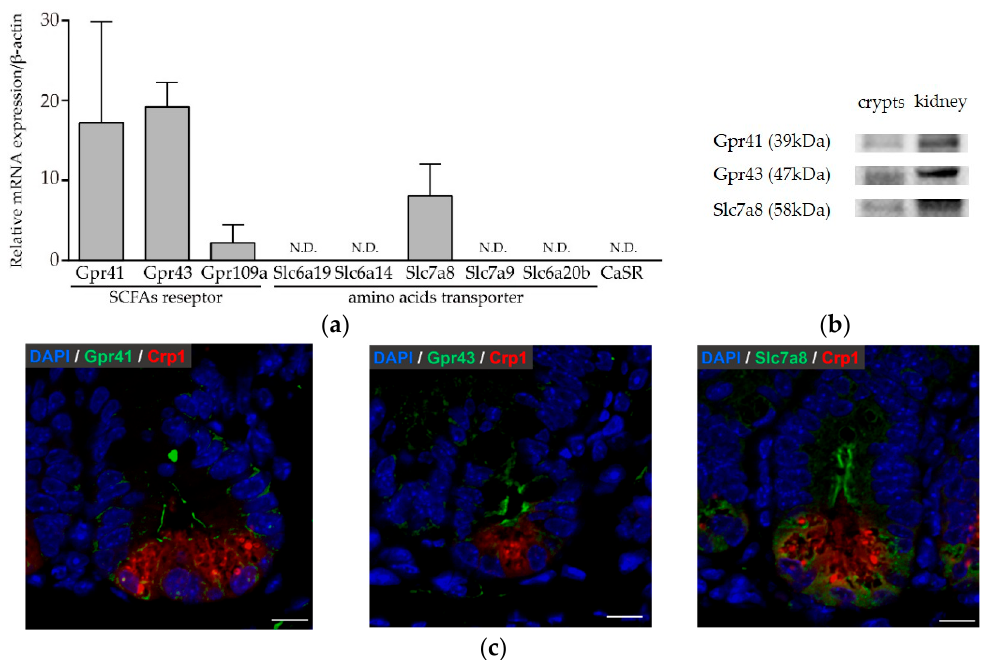
Figure 3. Expression of receptors and transporters recognizing short-chain fatty acids or amino acids in Paneth cells: ( a ) Relative expression of mRNA is shown by the 2 ∆ Ct method as the means ± SEM ( n = 3). ( b ) Western blot analysis of Gpr41, Gpr43, and Slc7a8 protein expression. Proteins were extracted from crypts of the mouse ileum and kidney. ( c ) Immunofluorescence staining of Gpr41, Gpr43, and Slc7a8 with Crp1 and 4’,6-diamidino-2-phenylindole (DAPI) in the mouse ileum. Scale bar: 10 µm.